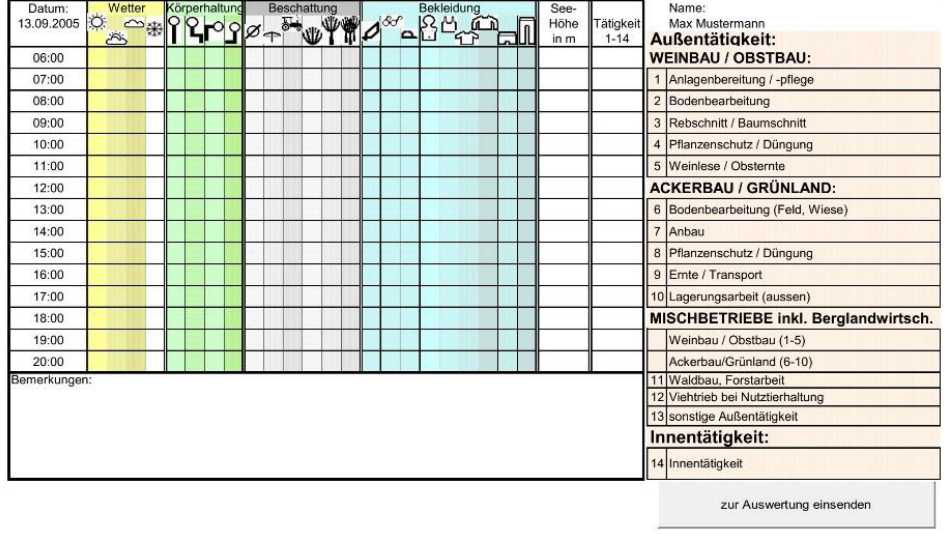
Figure 1. Example of an (electronic) diary based on the idea of Corbett et al. [26] designed for a farmer study. Recorded are weather, posture, shadow, clothing, altitude and activity (adapted from [27].